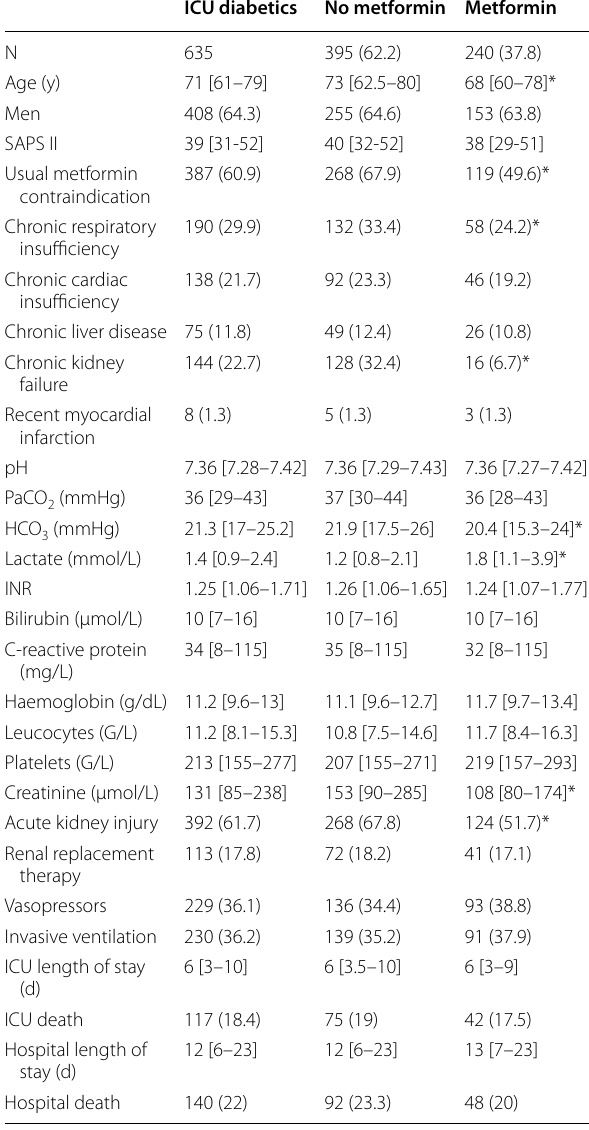
Table 1 Cohort of ICU diabetics: main characteristics at ICU admission, during ICU stay and ICU/hospital